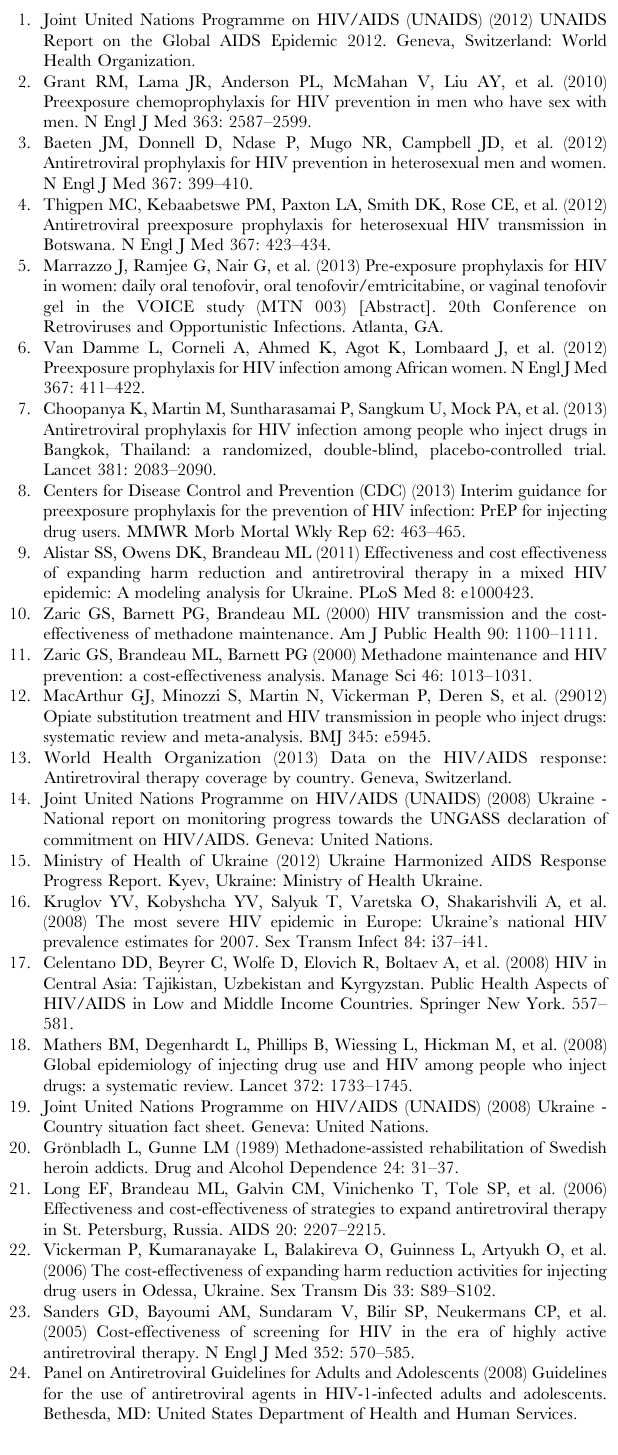
Schematic of model. Table S1 Summary of notation for parameters and variables. Table S2 Parameter values, ranges and sources. Table S3 Initial population distribution for the model. Table S4 HIV infections averted: results of one-way sensitivity